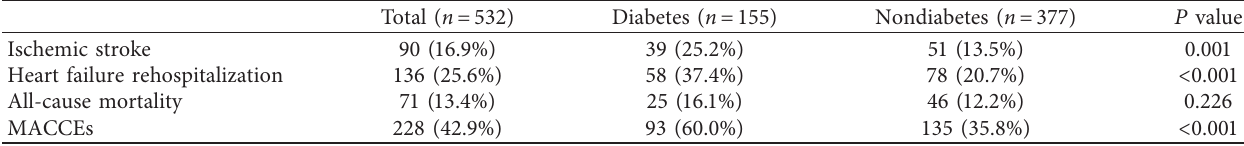
Table 2: Outcomes according to diabetes mellitus in elderly VHD patients.